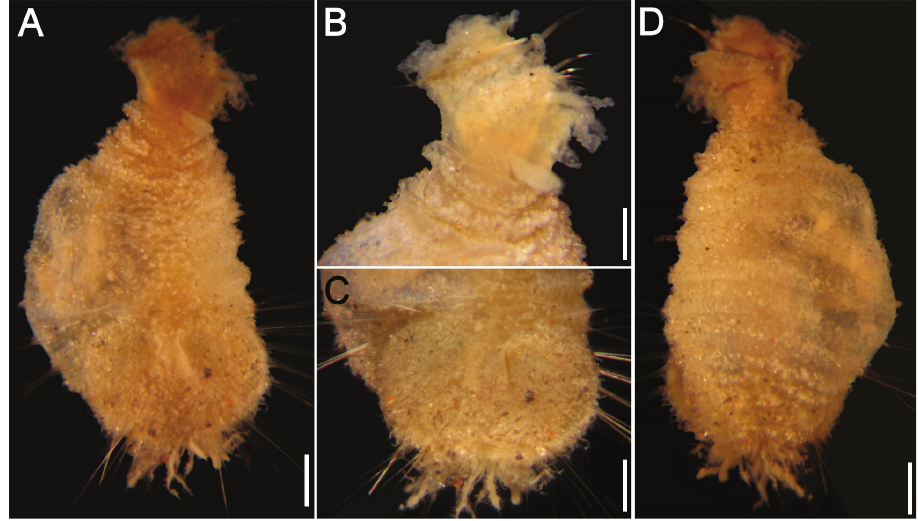
Figure 2. Caulleryaspis fauchaldi sp. n., juvenile specimen (LACM 5362) A Ventral view B Anterior end, ventral view C Ventro-caudal shield, frontal view D Dorsal view. Bars: A, C, D 0.38 mm B 0.26